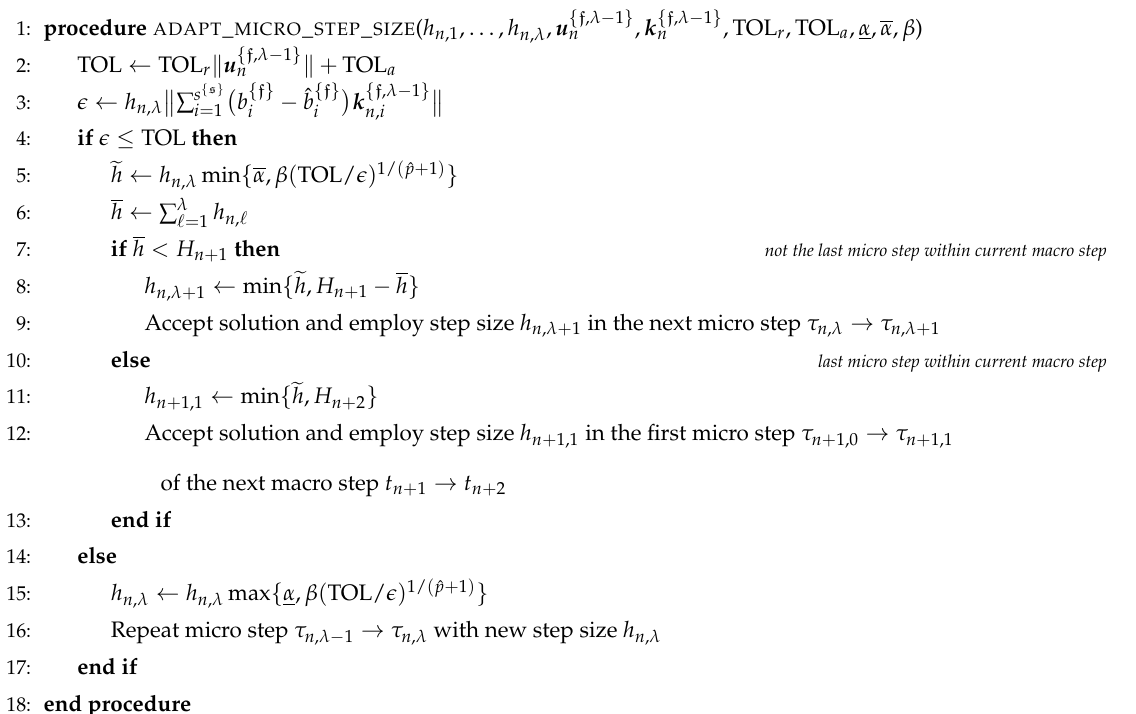
Algorithm 4 Adaptive step size determination for micro step τ n , λ